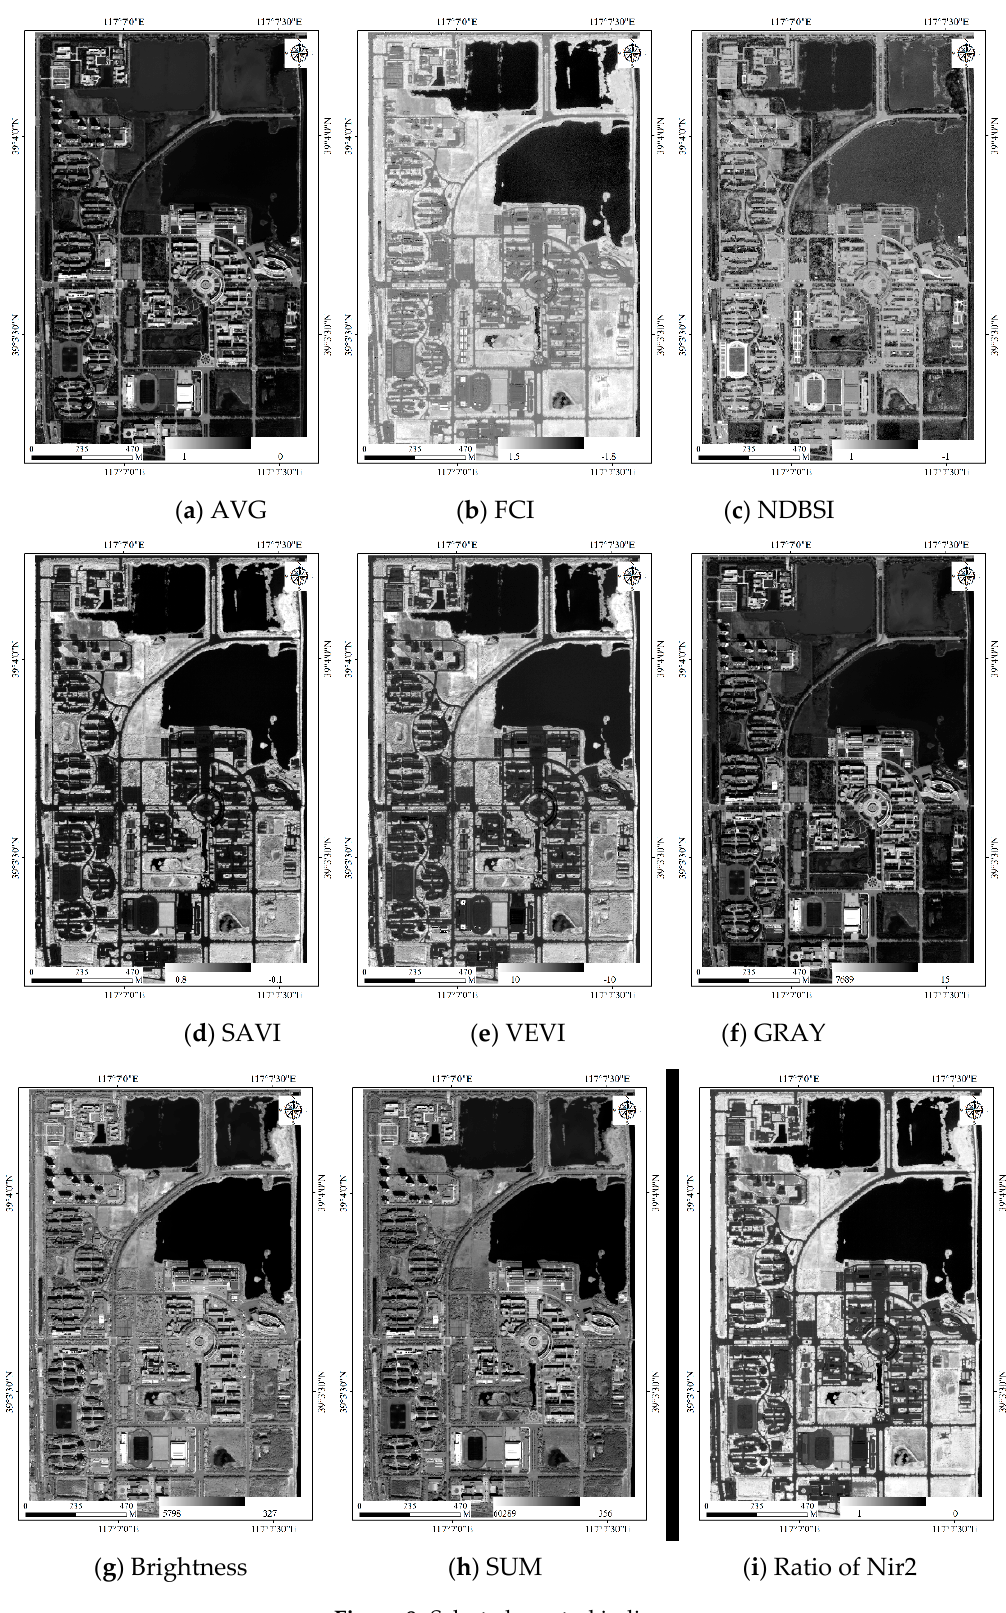
Figure 8. Selected spectral indices.